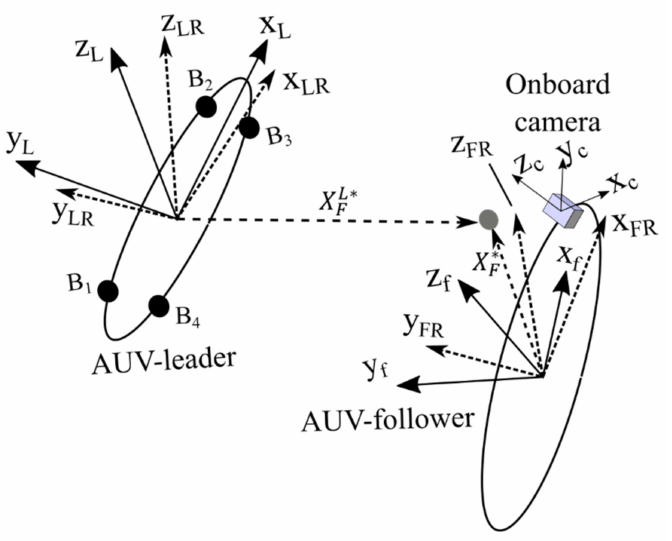
Figure 1. Scheme of leader–follower